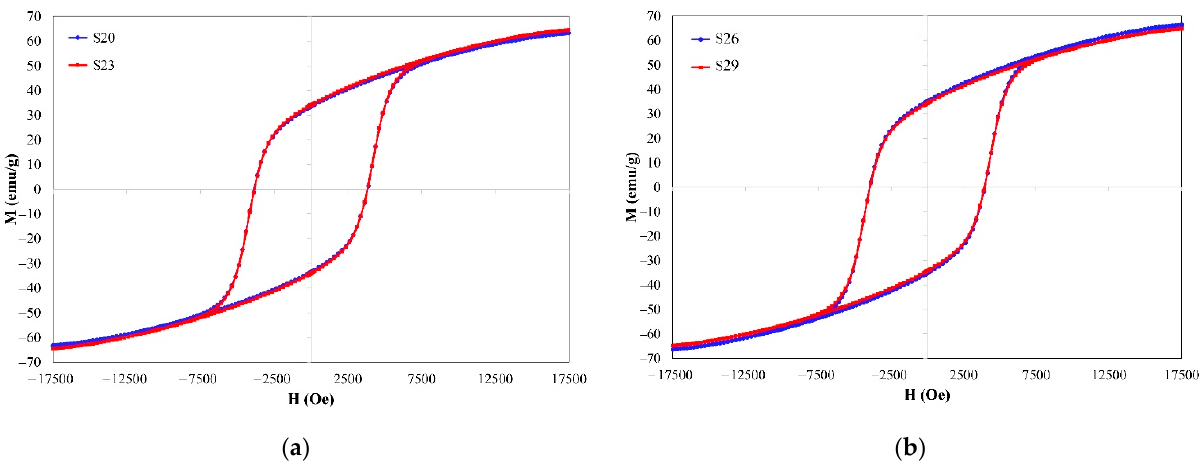
Figure 5. Hysteresis loops of ( a ) samples S20 and S23; and ( b ) samples S26 and S29.